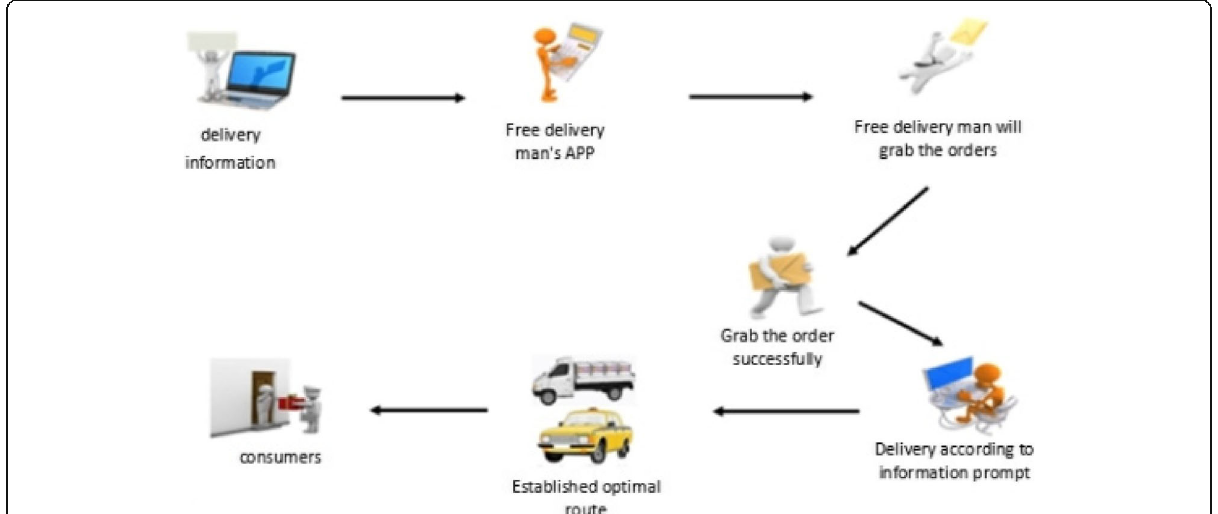
Fig. 3 The distribution flow diagram for individual customers. The flow of crowdsourcing logistics is that the consumers deliver express delivery information; the delivery man receives the information on the app and then collects the order. The successful delivery man distributes packages according to the information provided by the consumer. First, he plans the most suitable route for driving. Then he drives according to the route. Finally, the package will be delivered to the consumer. This completes the whole distribution activity. The cost of crowdsourcing logistics is low, it can effectively integrate the resources, and the delivery men are based on voluntary part-time people, the cost of human resources is greatly reduced, compared with the high human capital of traditional enterprises. Crowdsourcing logistics has a great advantage. In addition, crowdsourcing is conducive to the integration of idle resources in society goods, avoiding the problem that bulky goods cannot be loaded. The refrigerated containers are shown in Fig. 4. The goods in the refrigerated container will already have been sorted and packed at the cold chain hub. Each refrigerator corresponds to a medium-end customer and